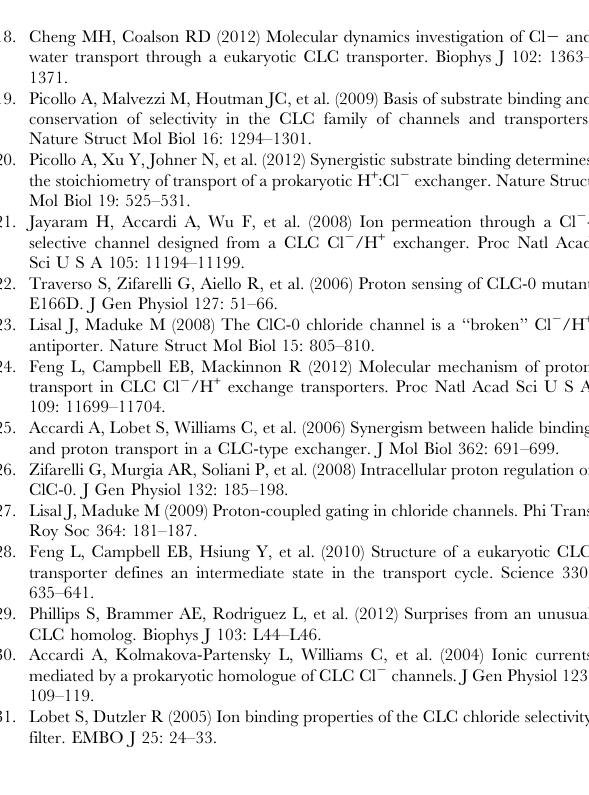
dashed lines. Water molecules were identified from maps of the B- subunit, which has systematically more crystallographic water densities. Figure S3 Effect of mutations on residues lining the polar pathway. Proton transport activities from each mutant CLC-ec1 was measured from reconstituted proteoliposomes as described in the main text. Figure S4 Large side chain mutations at E202 rate-limit H + transport. Cl 2 transport rates c o of the indicated E202 substitutions (filled bars) are normalized to the rate of the accompanying background construct (open bars). The completely uncoupled E148A and EAYS (E148A/Y445S) background constructs do not transport H + . Figure S5 Stereo view of E202Y mutant near Cl 2 binding site. Cl 2 ion bound in Cl 2 cen is shown in green. 2F o -F c map is contoured at 1.0 s . Figure S6 Coupling of Cl 2 /H + transport in E202 mutant transporters. (a) Cl 2 (green) and H + (blue) transport in indicated CLC-ec1 antiporters. Red dashed line shows initial velocity of ion movements. Scale bars indicate 100 nmole of Cl 2 or H + and 10 s.